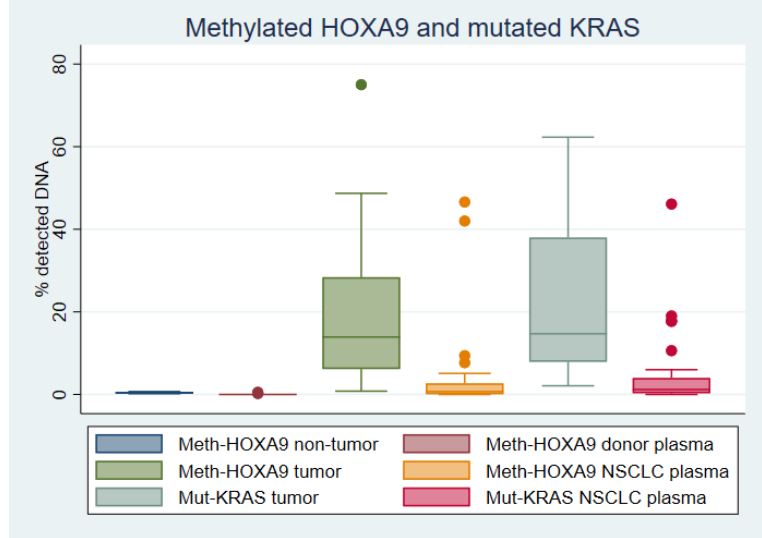
Figure 1. Levels of methylated Homeobox A9 (meth-HOXA9) and mutated Kirsten rat sarcoma viral oncogene homolog (mut-KRAS) in tissue and plasma. Boxplot depicting the level of meth-HOXA9 in non-malignant lung tissue ( n = 20), plasma from healthy donors ( n = 100), lung adenocarcinoma tissue ( n = 48), matched plasma from lung adenocarcinoma patients ( n = 48), and level of mut-KRAS in lung adenocarcinoma tissue ( n = 34) and matched plasma ( n = 34).